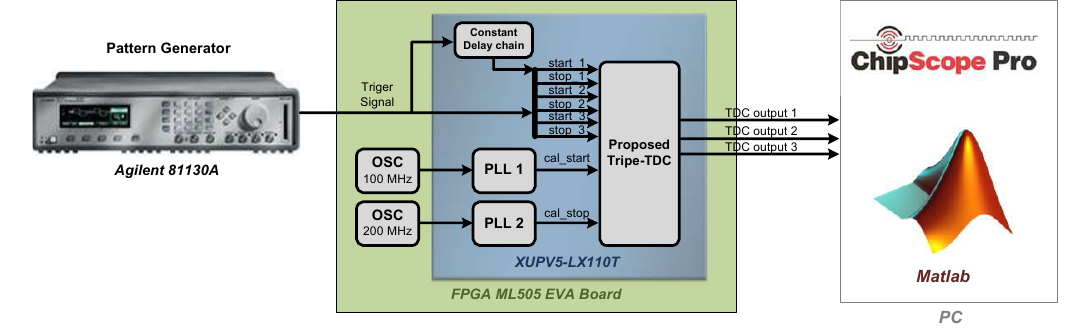
Figure 6. Measurement environment of this